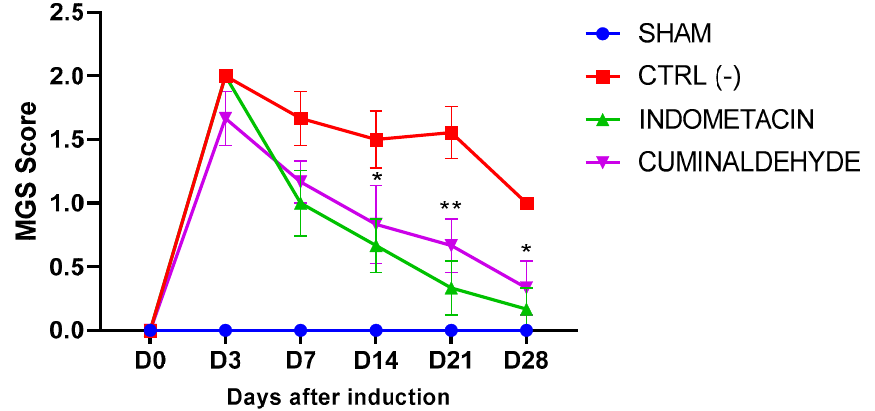
Figure 3. Effect of cuminaldehyde in the evaluation of spontaneous pain by the Mouse Grimace Scale score. Results are expressed as mean ± standard error of the means (SEM). * Significant differences, at p < 0.05; ** at p < 0.01. * compared to saline (CTRL-) group. (Two-way ANOVA; Tukey). (D = day).